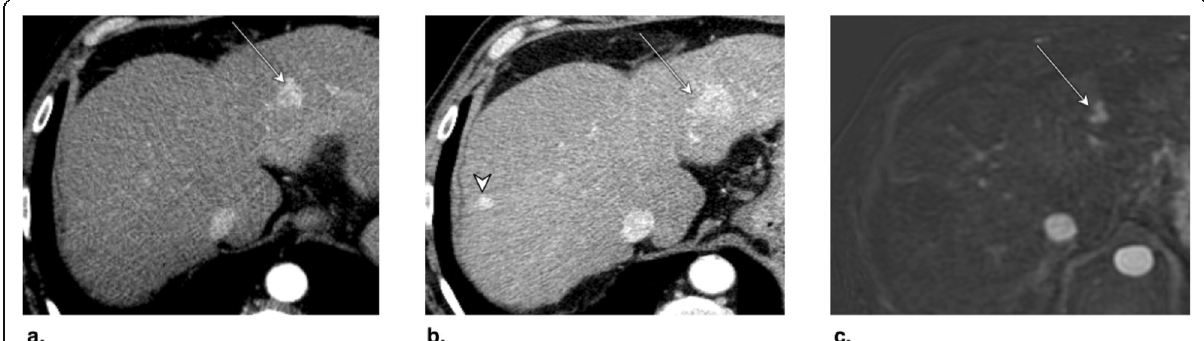
Fig. 9 Axial CT in late arterial phase (AP) obtained ( a ) pretreatment: image shows nonrim arterial phase hyperenhancement (APHE) of a 2-cm LR- 4 observation in segment II-III (arrow). b 2 months post percutaneous ethanol ablation (PEA): image shows interval growth (arrow) and a new LR- 4 observation (arrowhead) in segment VIII. At this point, the treated lesion is categorized LR-TR viable. c Axial T1-weighted subtraction MR in late AP obtained 1 month post repeat PEA: image shows serpiginous enhancement in the location of the treated lesion possibly representing vascular fistula. The treated observation is categorized LR-TR Equivocal